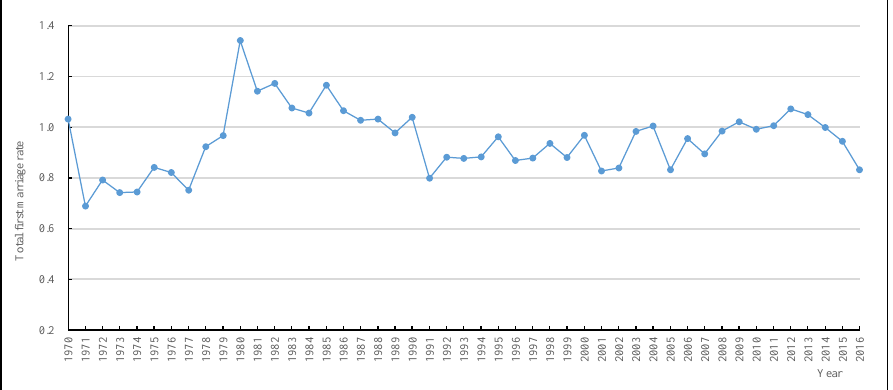
Figure 1. Total first marriage rate trends of Chinese women from 1970 to 2016. Source: 2005 China 1% Population Sample Survey and the 2017 China Fertility Sample Survey.